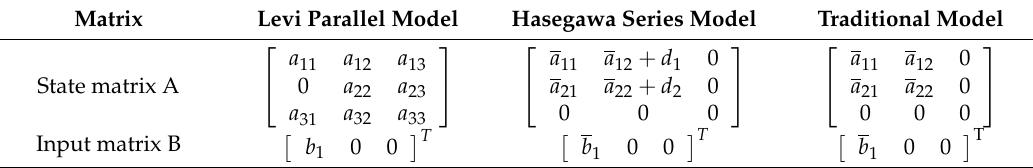
Table 1. Matrix parameters comparison of the three models.